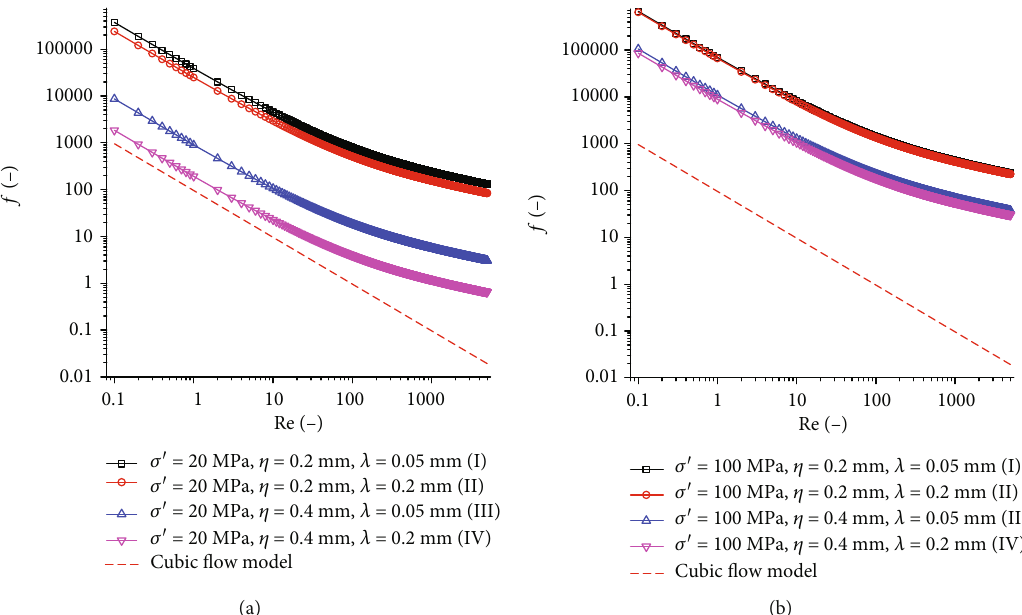
Figure 22: In fl uence of geometry parameters η and λ on the friction factor under loading stresses of (a) 20MPa and (b)